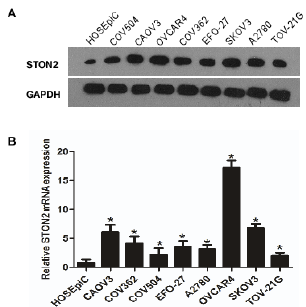
Figure 1. STON2 mRNA and protein overexpression in ovarian cancer cell lines. The expression of STON2 mRNA and protein in ovarian cancer and HOSEpiC cell lines was examined by Western blotting ( A ) and real-time PCR ( B ) . The expression levels were normalized to the expression of GAPDH . Error bars: standard deviation (SD) of the mean from three parallel experiments. ( * p < 0.05) .